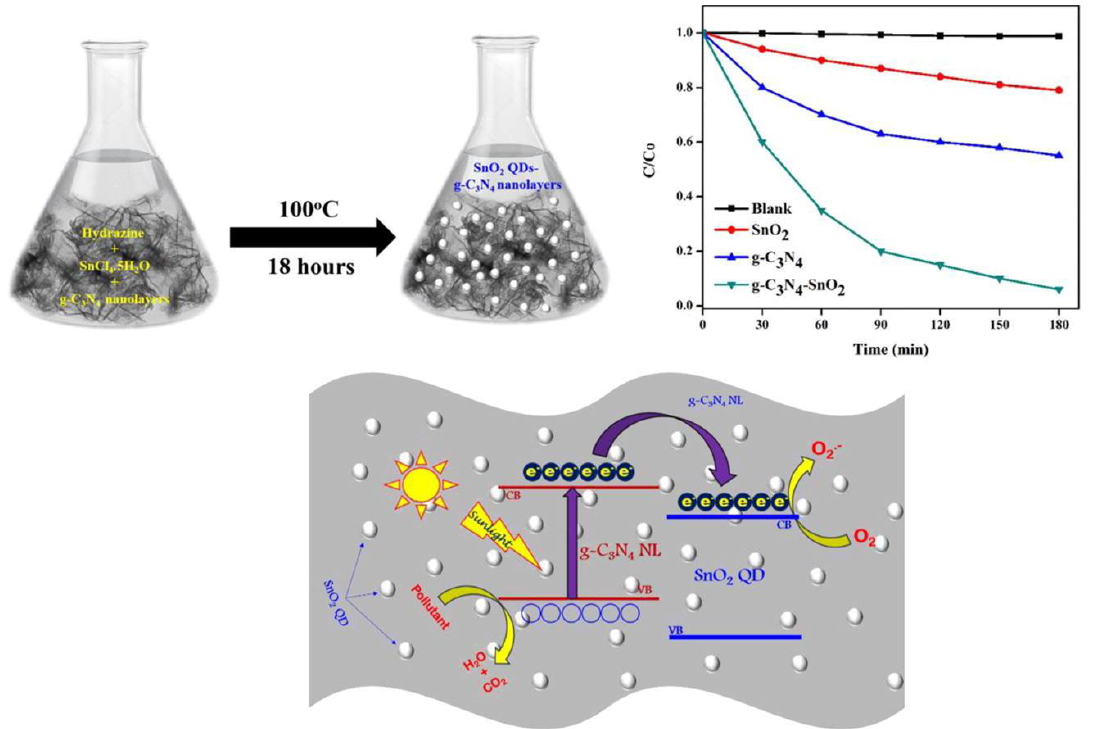
2 QDs [35], Copyright 2020, ACS.